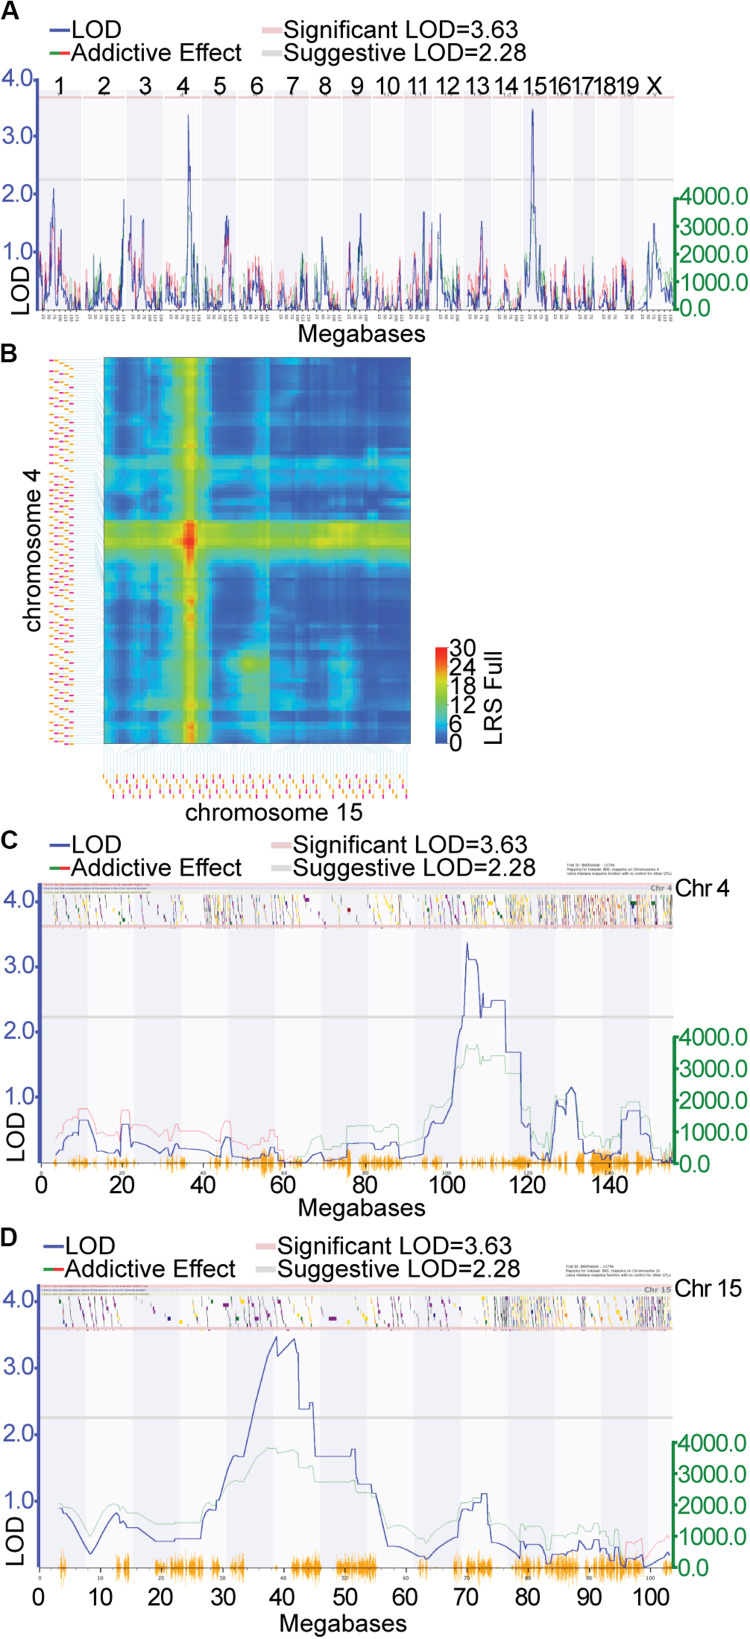
Quantitative trait locus (QTL) mapping of cocaine response in the expanded BXD RI genetic reference population: QTL mapping of locomotor response following the second injection of cocaine in females resulted in the detection of suggestive QTLs on Chr 4 and Chr 15. (A) Green lines indicate regions where DBA/2J is associated with increased phenotypic effect the increaser allele, red lines indicate that C57BL/6J is associated with the increased phenotypic effect. (B) The two QTL additive model involving Chr 4 and Chr 15. Additive the black horizontal lines represent the 1.5 LOD support interval on Chr 4 (C) and Chr 15 (D). The LOD support interval on Chr 4 spans 101.10 (rs13477873) 114.51 (gnf04.110.583) Mb, while on Chr 15 it spans 33.43 (rs8267966) 45.11 (rs13482547) Mb. 108 and 61 positional protein coding candidate genes reside in the Chr 4 and Chr 15 intervals, respectively.